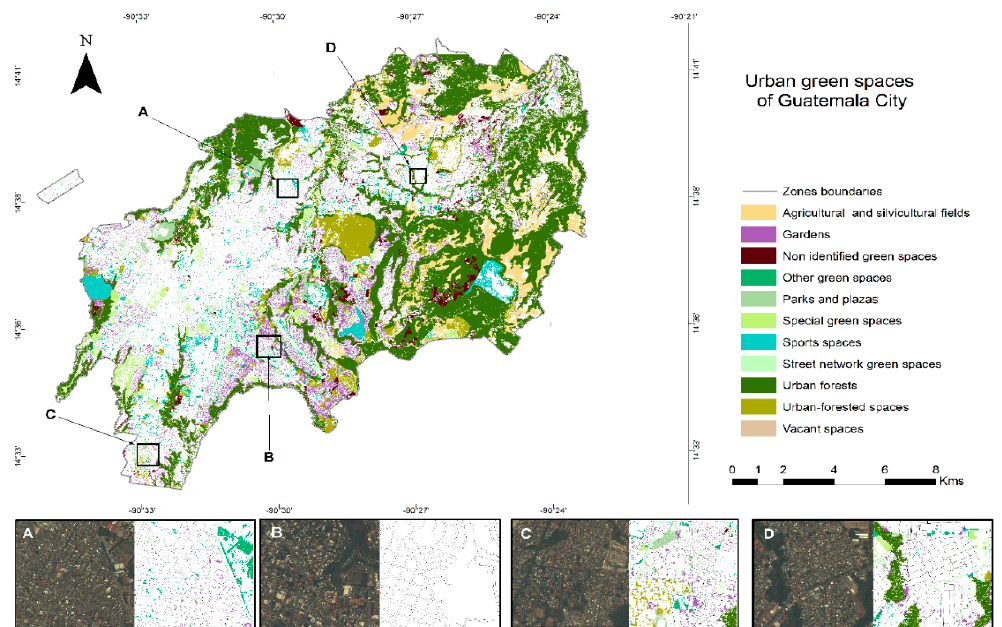
Figure 5. Urban green spaces (UGS) in Guatemala City. The visual representation of the distribution of green spaces types is shown here. Boxes below show detail of four zones of the city. To the left is a true color composition of WorldView-2 image and the right represent UGS. A depicts part of zone 6, B represents a piece of zone 15, C shows a zone 21 portion and D reveals part of zone 18.